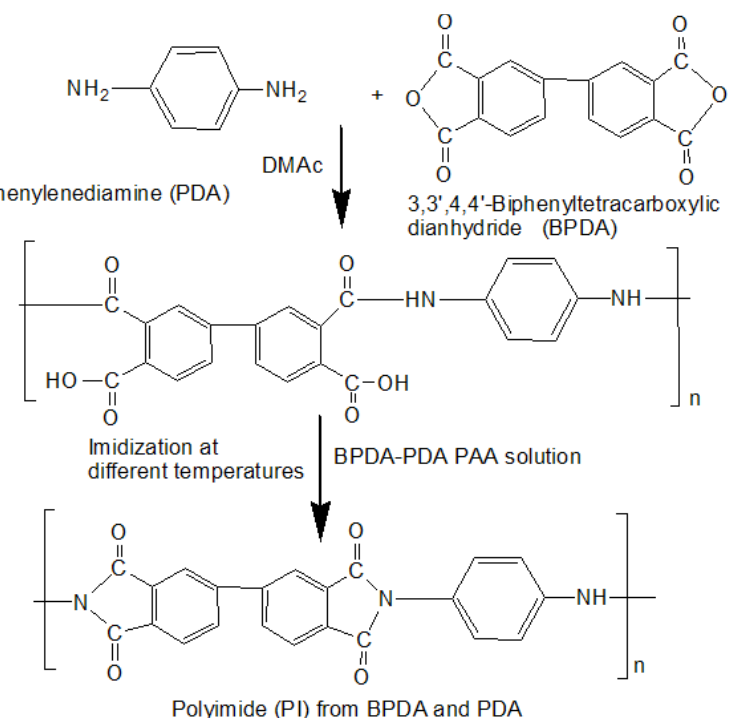
Figure 1. Synthesis of BPDA-PDA PAA solution and fabrication of PI film.